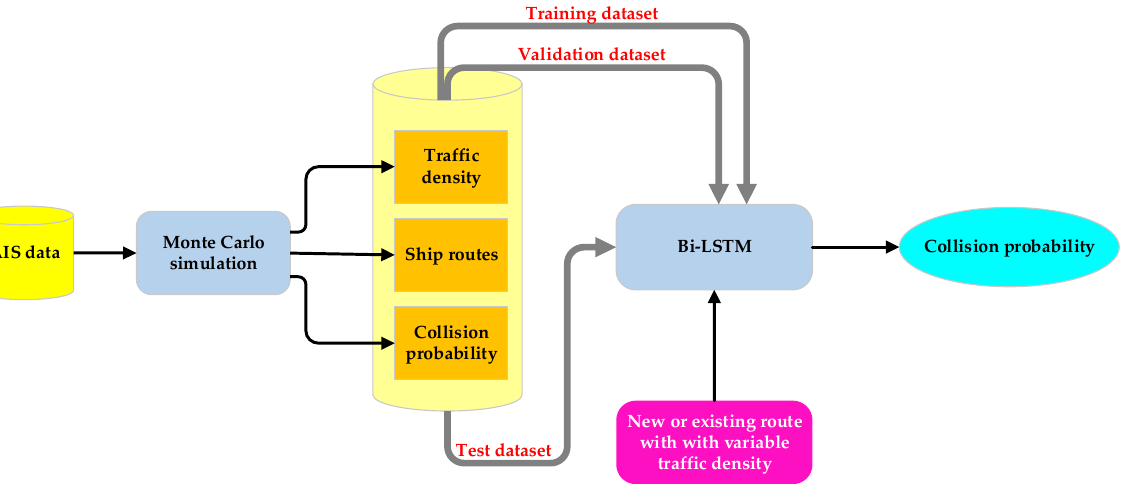
Figure 5. Proposed block diagram of a model for collision probability estimation using MC and Bi-LSTM.